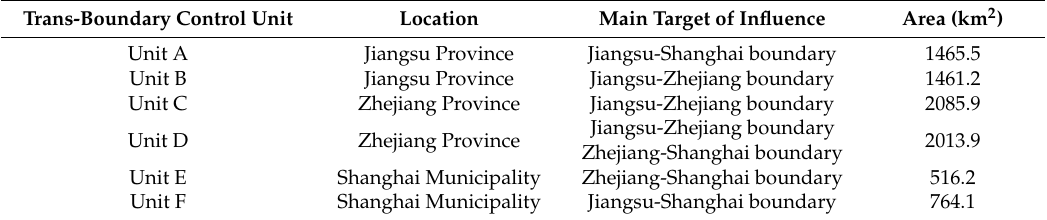
Figure 6. Trans-boundary effect control scope (TECS) and control units of the plain river network in Taihu Basin. Table 3. Details of trans-boundary control units in the trans-boundary effect control scope (TECS).